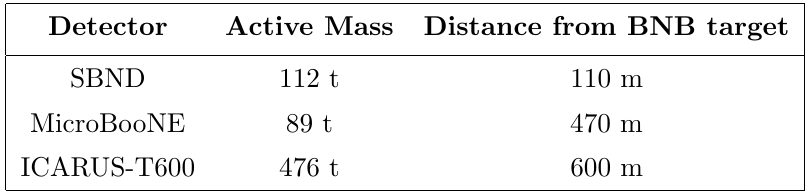
Table 1 . SBN detector active masses and distances from the local of the neutrino production.